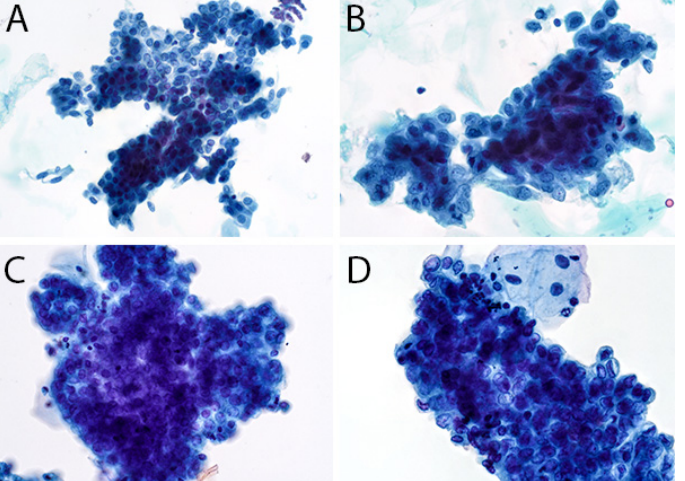
Figure 4. ( A , B ), Two tissue fragments from a specimen diagnosed as AUC with benign follow-up. ( A ), The nuclei appear enlarged, some with elevated N/C ratios, but are similar in size and have regular nuclear contours. Several columnar cells are attached to the edges; cells with such morphology can be seen in patients with cystitis glandularis but also low-grade urothelial neoplasms. ( B ), The nuclei in a second fragment have some nuclear size variation and nuclear membrane irregularities. However, the chromatin is bland, with nuclei containing 1–2 small chromocenters; furthermore, many of the cells at the edges lack elevated N/C ratios. ( C , D ), Two tissue fragments from a specimen diagnosed as SHGUC with malignant follow-up. ( C ), There is significant nuclear overlap in this fragment, which makes a morphologic assessment challenging. The nuclei appear mostly the same size. ( D ), By comparison, this second fragment has more atypical features, with more significant anisonucleosis and nuclear contour irregularities. When assessed at the edges of the fragments, the N/C ratios appear elevated. The chromatin lacks the coarse, clumpy pattern and instead appears paradoxically